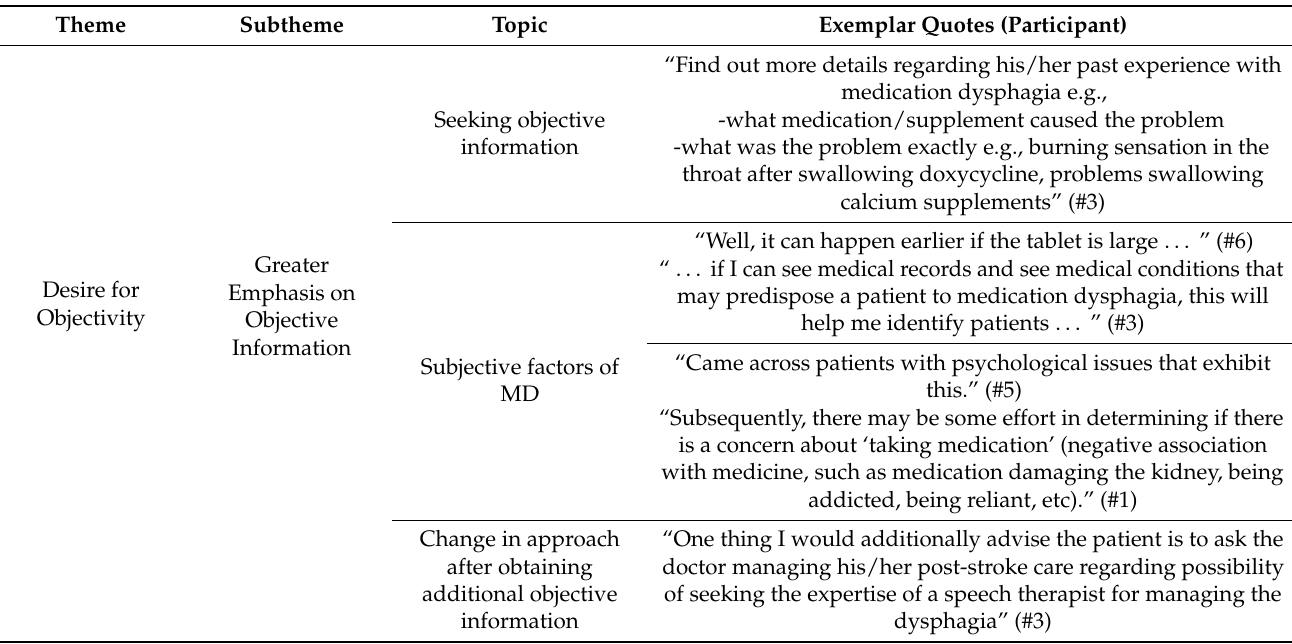
Table 5. Major theme of desire for objectivity, corresponding subthemes, and exemplar